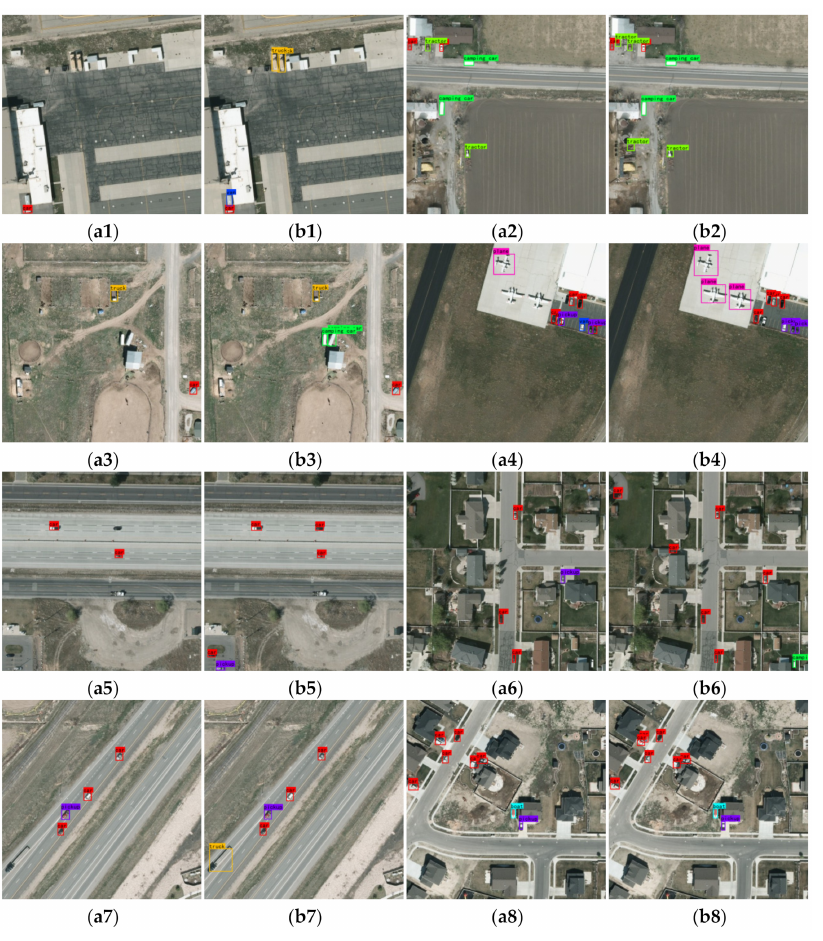
Figure 9. Detection results on the VEDAI dataset: ( a1 – a8 ) and ( b1 – b8 ) are the detection results of YOLOv4 and our proposed method, respectively.